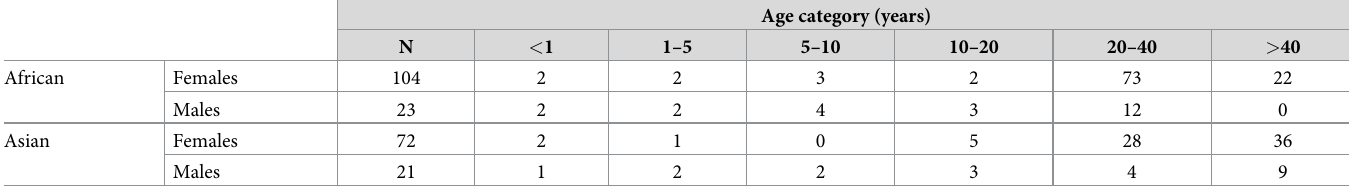
Table 1. Species, sex, and age distribution of elephants included in the study (N =